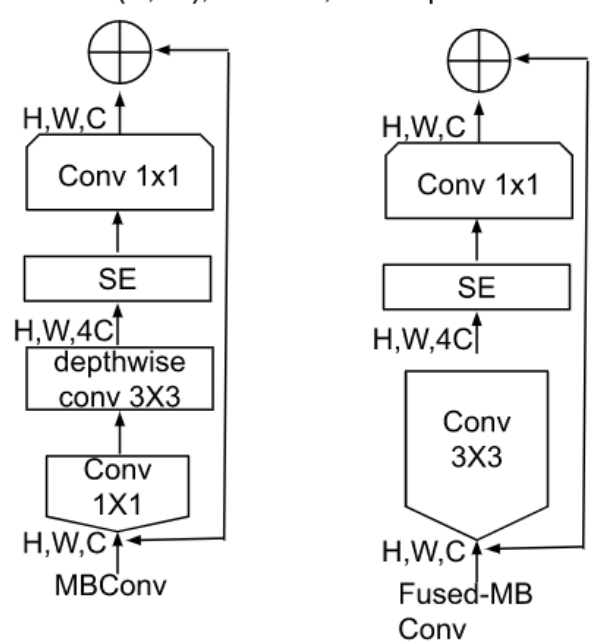
Figure 2. Architecture of MBConv and